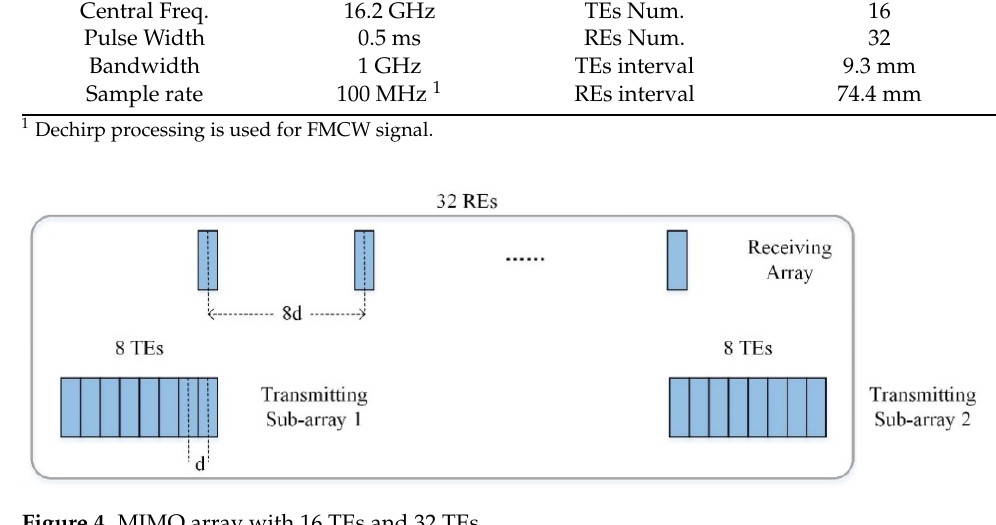
Figure 4. MIMO array with 16 TEs and 32 TEs. Table 1. System parameters for MIMO radar simulation. Table 2. Prominent target positions in